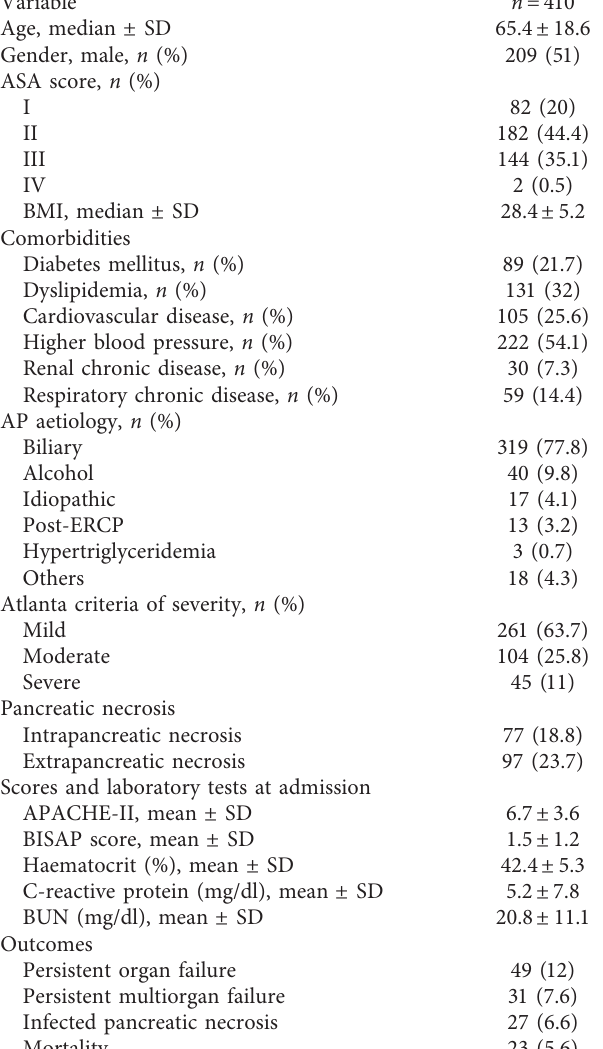
Table 1: Basal population